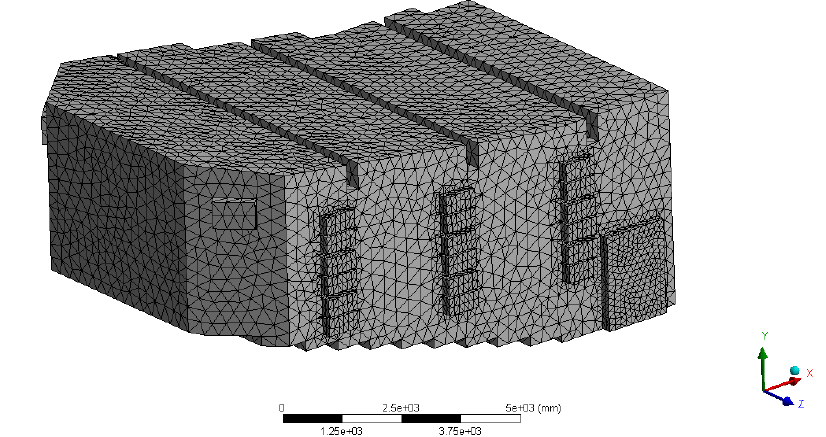
Figure 7. Mesh representation of